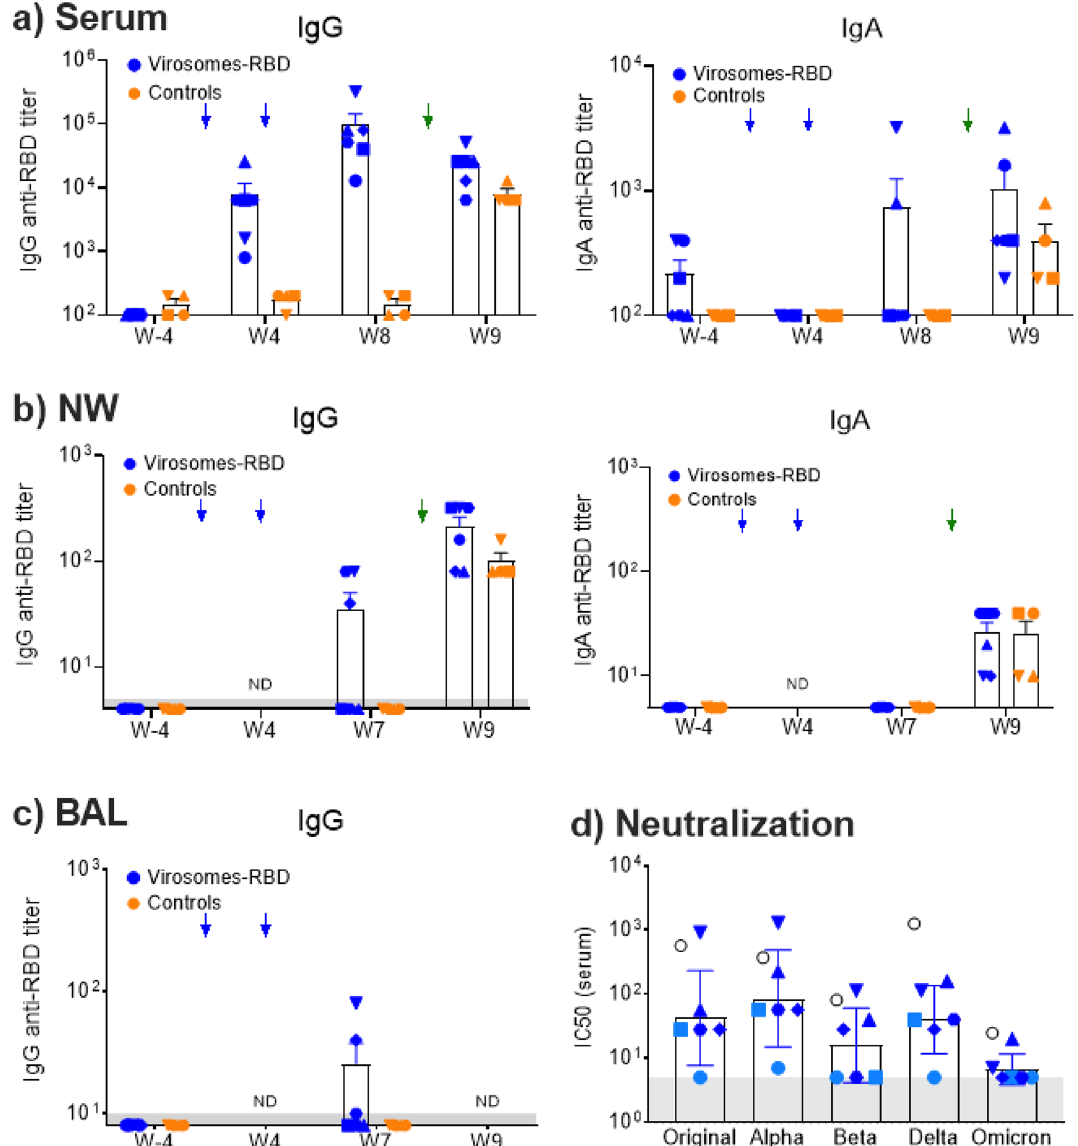
Figure 3. RBD specific IgG and IgA ELISA and serum neutralizing activity. ( a ) ELISA serum IgG (left graph) and IgA (right graph) antibody titers overtime toward SARS-CoV-2 RBD are shown for the vaccinated and control group. Serum IgG titers at week 4 ( p = 0.0095) and week 8 ( p = 0.0095) are significanlty higher in the vaccinated group than the control group, but at week 9 there is no significant difference ( p = 0.076). ( b ) ELISA nasal wash (NW) IgG (left graph) and IgA (right graph) antibody titers overtime against SARS-CoV-2 RBD. ( c ) ELISA BAL IgG (left graph) antibody titers overtime against SARS-CoV-2 RBD. Each animal is represented by a symbol, blue for vaccinated animals and orange for control animals. Mean and SEM are shown in columns for each group of animals. Blue arrows indicate the day of immunization at week 0 and week 4, green arrow the day of the challenge at d56/week 8. For IgA in serums, NWs and BALs, there was no significant difference between the groups ( p > 0.05). ( d ) Individual serum neutralizing antibody titers from week 8/d56 were determined by neutralization assays with five different live SARS-CoV-2 strains. The determined geomean (GM) neutralizing titers (NT) are the following: Italian strain INMI1 from 2019 as an original Wuhan-like (GM NT 42), Alpha with the Beta ( p = 0.125) and Delta strain ( p = 0.750), but a higher neutralizing titer against the Alpha strain was observed ( p = 0.031). However, we observe an apparent reduced neutralizing activity toward the Omicron strain, respective to the Wuhan. The closed circles and squares in light blue are animals with the lowest serum RBD titers that are also the oldest animals. NIBSC 21/234 serves as a positive control (open black circle). The grey area is the baseline observed for pre-immune neutralizing activity (dilution 1/5), and serums for the V1 and V2 old animals. Data points beneath this area are below the detection